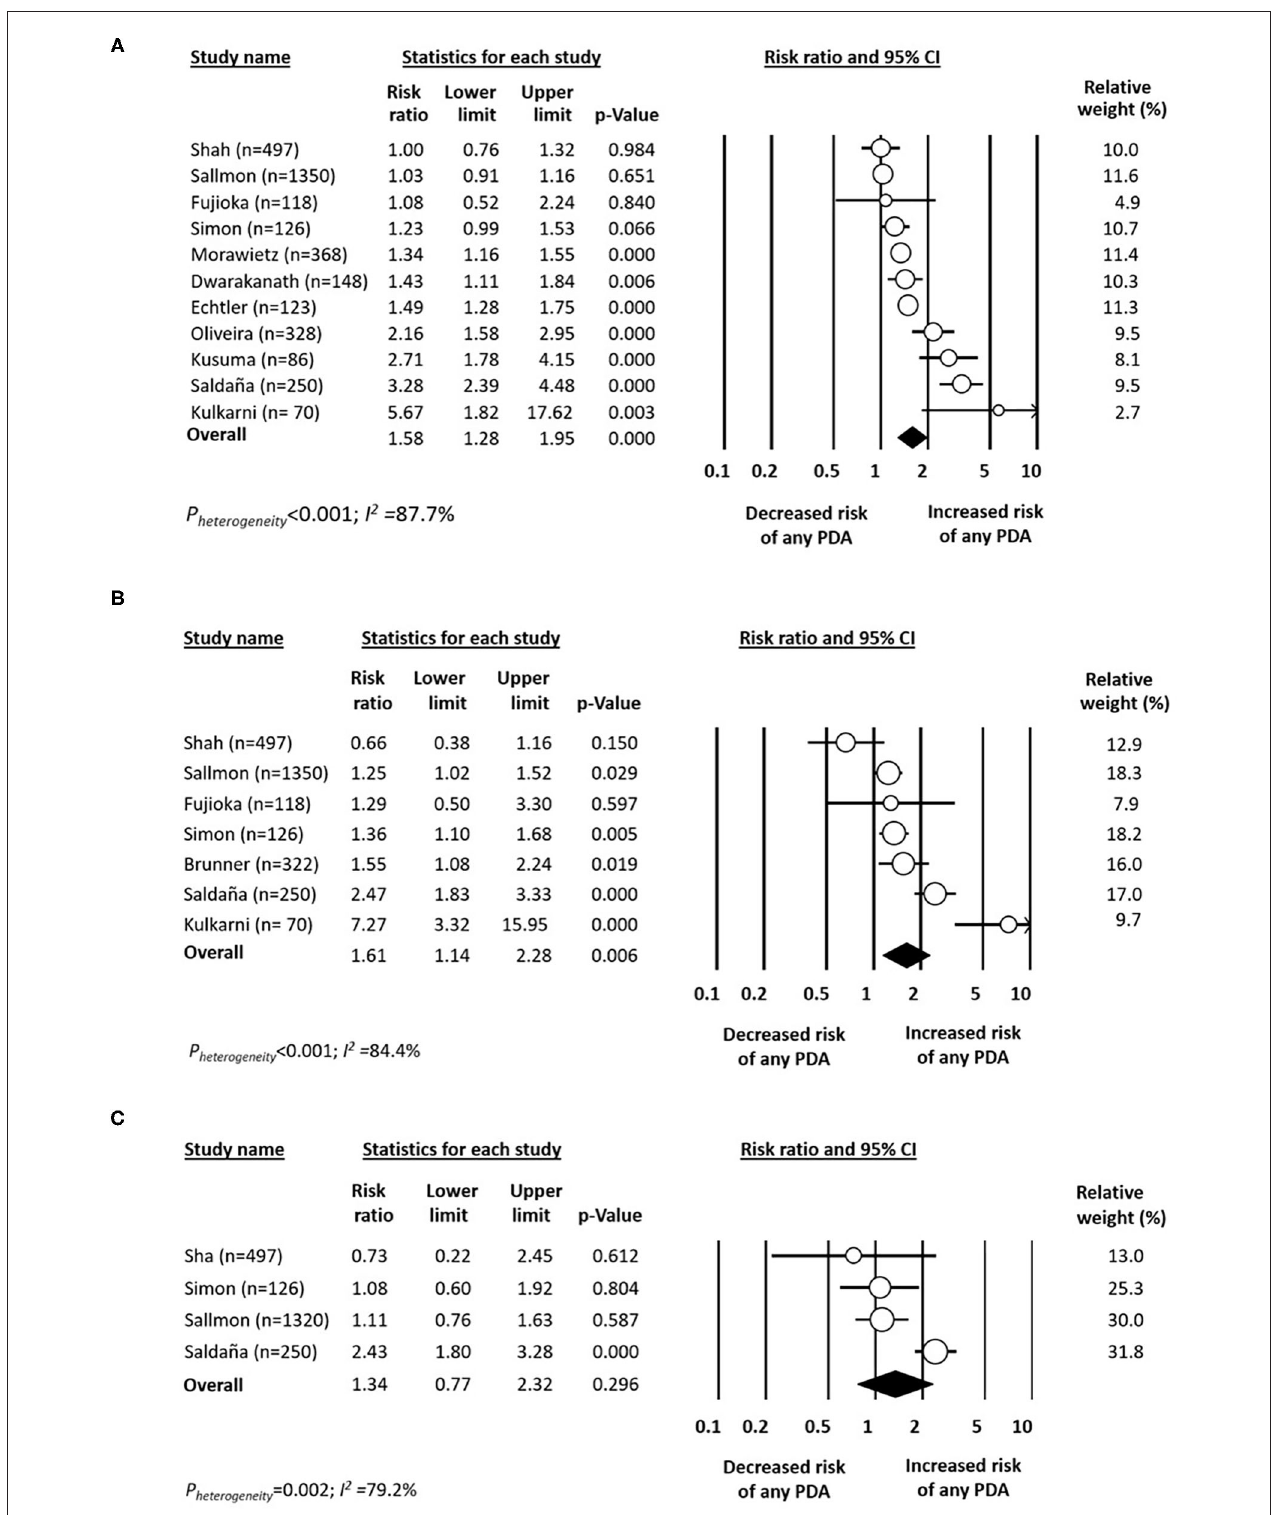
FIGURE 1 | Forest plot for studies examining the association between platelet counts below (A) 150 × 10 9 /L, (B) 100 × 10 9 /L, and (C) 50 × 10 9 /L in the first day(s) of life on patent ductus arteriosus (PDA). Risk ratio > 1 indicates increased risk of PDA.